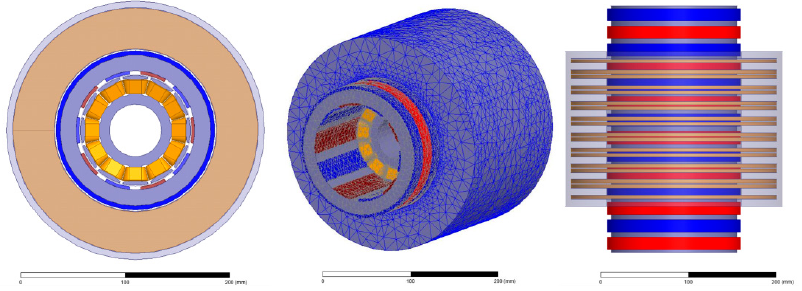
Figure 10. 3D FE model and its mesh.